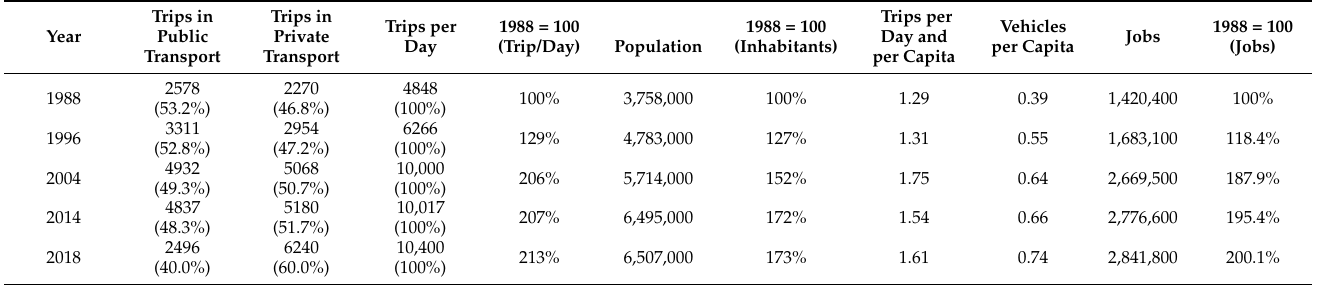
Table 3. Evolution of trips by public transport and private transport in the Community of Madrid. Source: Mobility Survey of 1988, 1996, 2004, 2014 and 2018 and Statistical Yearbook of the Community of Madrid. 1985–2020 Transport and